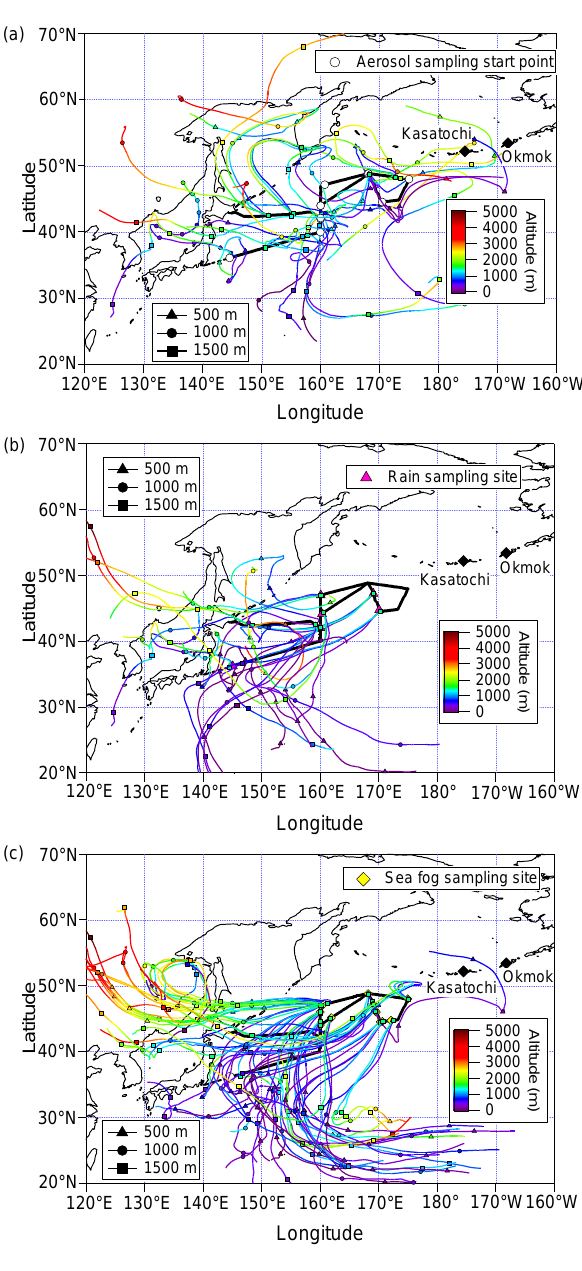
Figure 5. The 168 h (7 days) air mass backward trajectories for starting altitudes of 500 (triangle symbols), 1000 (circle symbols) and 1500 m (square symbols) above ground level (AGL) during the collections of aerosol (a), rain (b), and sea fog (c) samples were calculated from the Global Data Assimilation System (GDAS) database of the National Ocean and Atmospheric Administration (NOAA) and simulated by using the Hybrid Single-Particle Langrangian Integrated Trajectory (HY-SPLIT) model (web site http://www.arl.noaa.gov/ready/hysplit4.html). White circles, pink triangles and yellow diamonds indicate aerosol, rain and sea fog sampling locations during the cruise, respectively. Kasatochi and Okmok volcanoes are black diamonds.